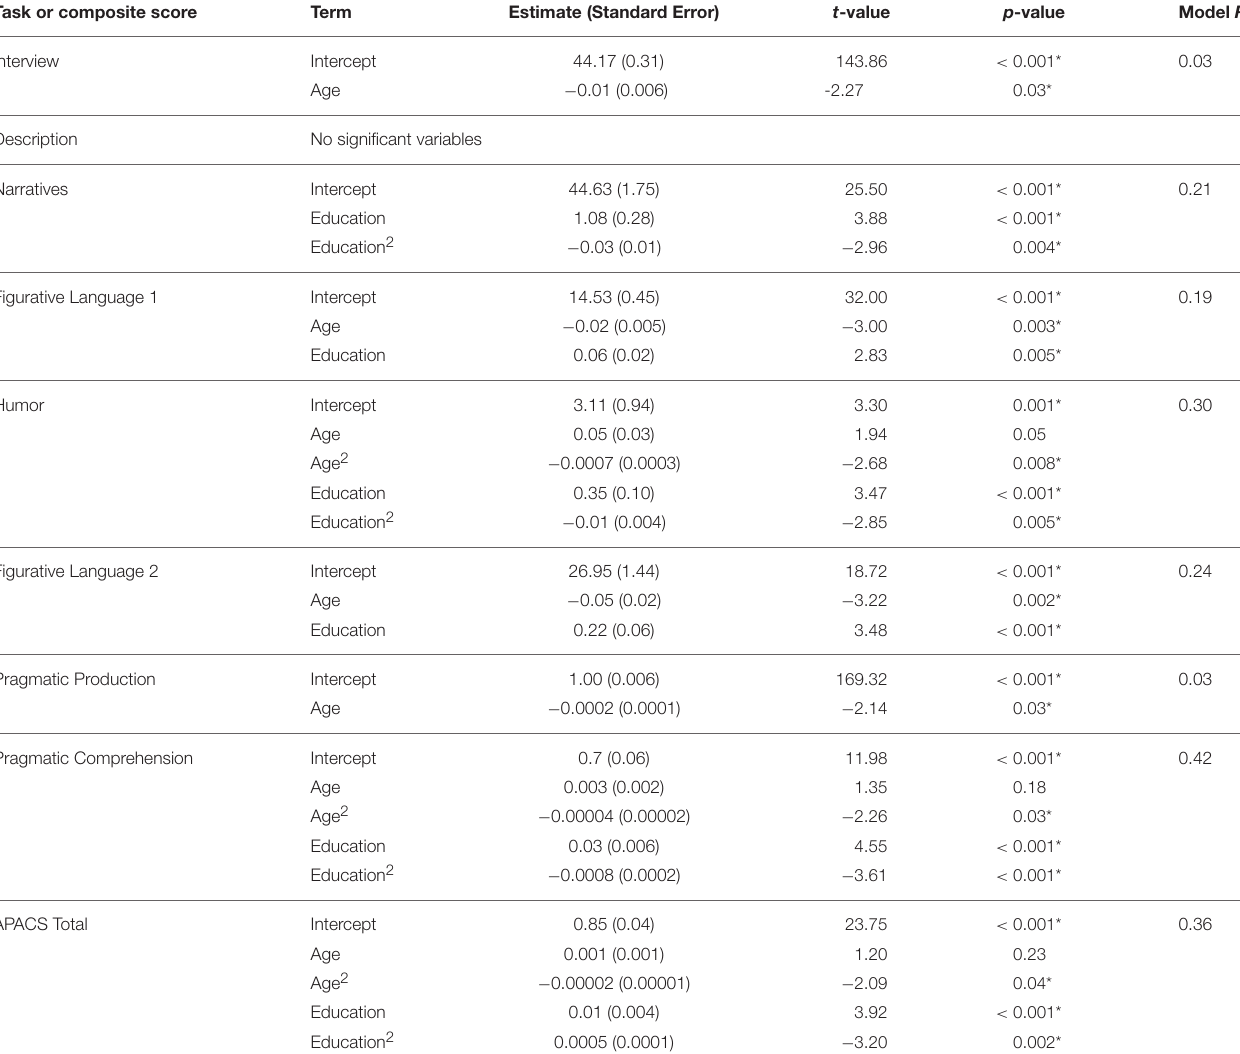
TABLE 7 | Effect of demographic variables on APACS tasks and composite